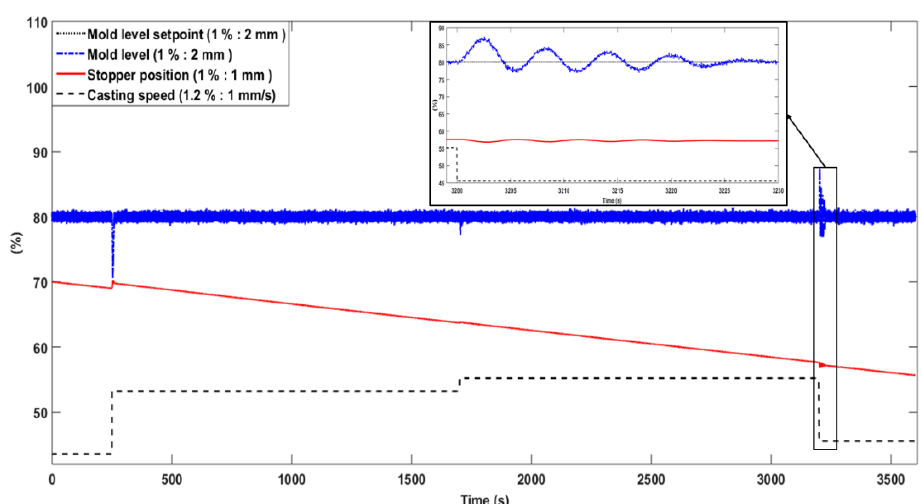
Figure 11. Simulation of conventional mold level control for a cast with medium SR erosion.